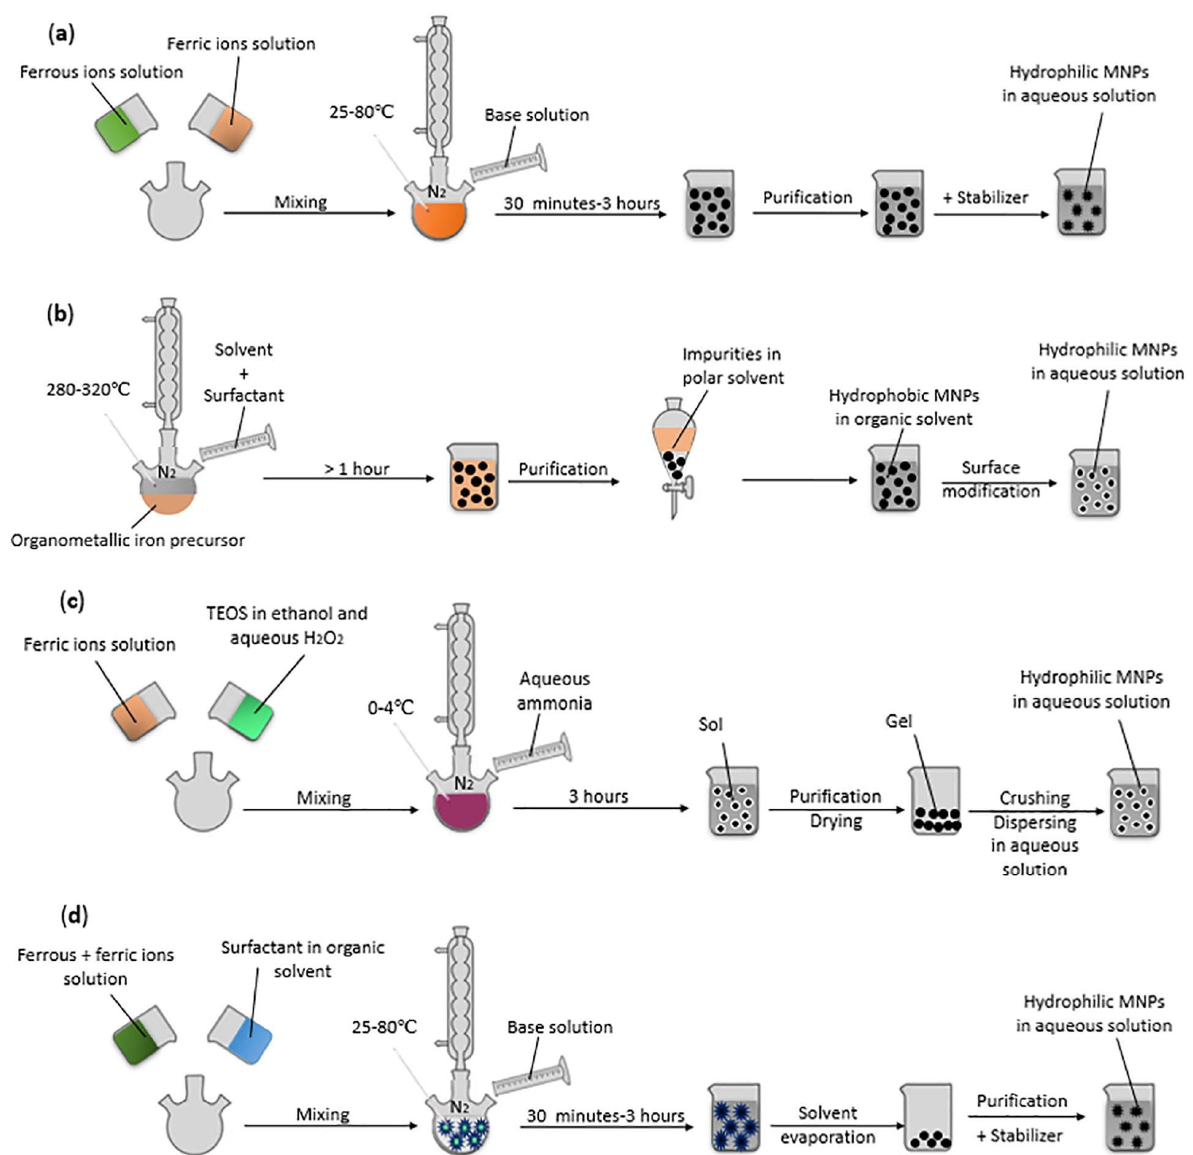
Figure 3. Schematic representation of commonly used synthesis methods to produce magnetite nanoparticles (MNPs): ( a ) co-precipitation; ( b ) thermal decomposition; ( c ) sol–gel; ( d ) microemulsion. Reprinted with permission from [49], © Elsevier, 2022.